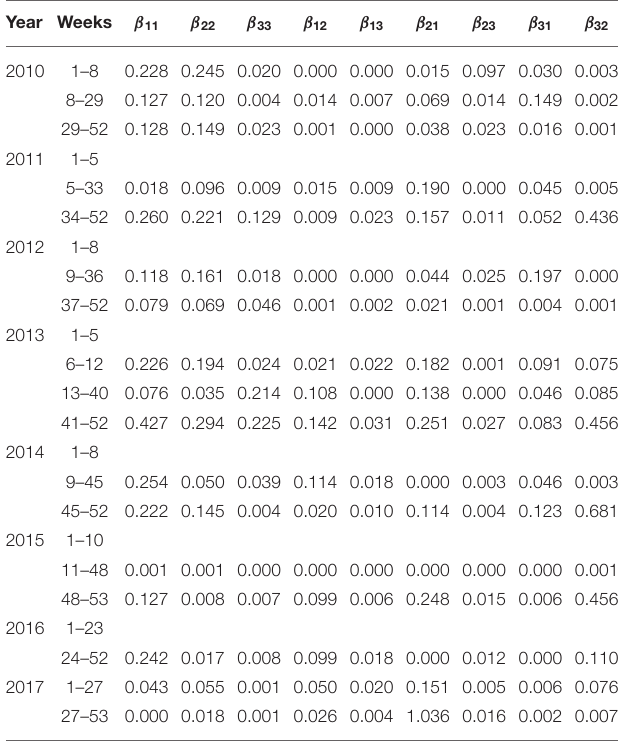
TABLE 3 | The P values and fitted R 2 values for each group. TABLE 4 | The weekly transmission coefficients β for each age